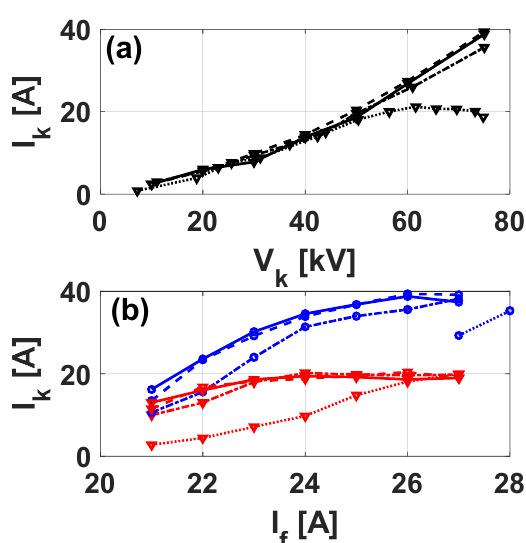
Fig 2. Klystron current for initial arc damaged cathode (..), and for conditioning times of 45min(-.), 105min(--), and 225min(-). Cathode current I k vs cathode voltage V k at 26A filament current is plotted in (a). Cathode current I k vs filament current I f at 50kV(red, ▼) and 75kV(blue, O) cathode voltage is plotted in